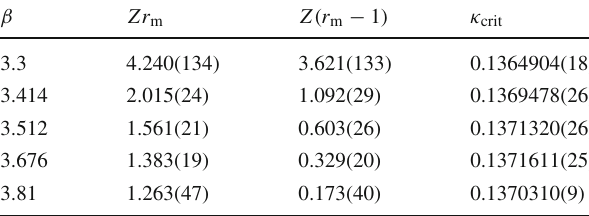
is. The vertical dashed line is positioned at κ crit from the linear fit; see Table3.The Zr m and Z ( r m − 1 ) valuesshowninthelegendareobtained from the linear term of the quadratic polynomial Table 3 Results from the PCAC mass analyses. The second and fourth column show results obtained in a unitary setup; the third column refers to the non-unitary